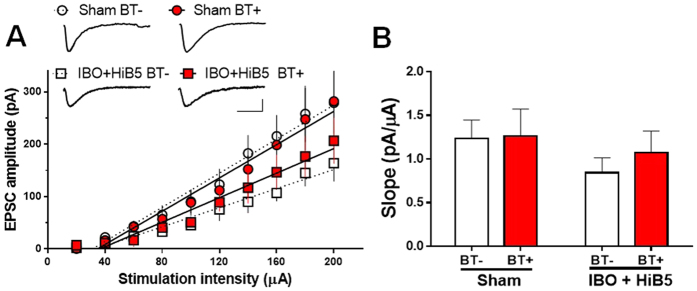
IA learning does not produce LTP at synapses onto endogenous CA1 pyramidal neurons.(A) Input-output relationships of EPSCs for endogenous CA1 pyramidal cells in the slices from the IBO-lesioned rats that received HiB5 cells (IBO + HiB5) and the saline-injected rats (Sham). Recordings were made in the endogenous CA1 pyramidal cells 1 day after IA learning (BT+). Homecage-control was used as a control (BT−). Insets demonstrate averaged current traces of five consecutive EPSC responses with input stimulations of 200 μA. Scale bars, 20 ms and 100 pA. (B) Comparison of the slopes calculated from the input-output curves shown in A. In each group, the slope of BT+ was not different from that of BT−. P > 0.05, unpaired Student’s t-test. Values are mean ± SEM.